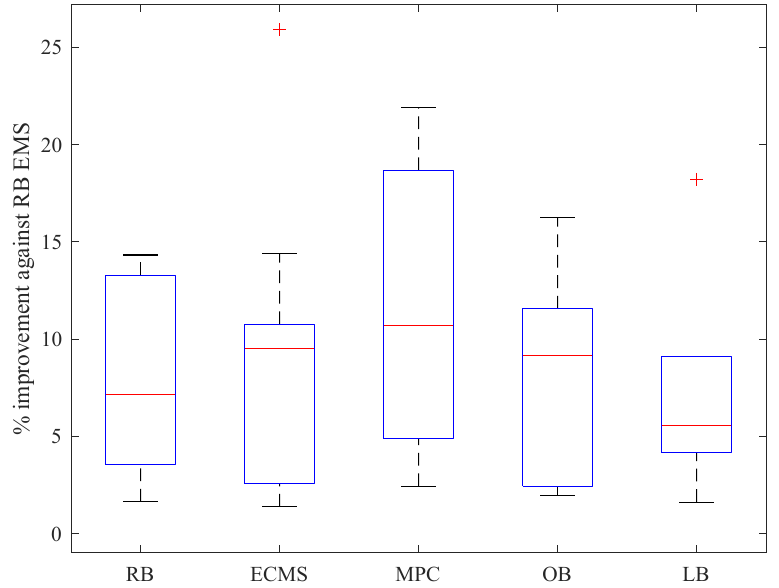
Figure 8. Fuel consumption improvement with respect to commercial RB EMSs.